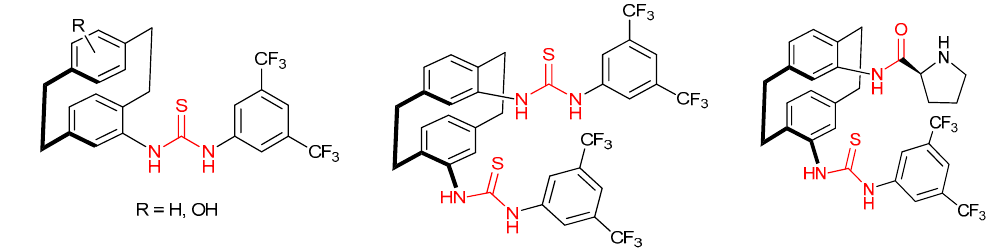
Figure 29. Examples of thioureas with planar chirality [31–33].